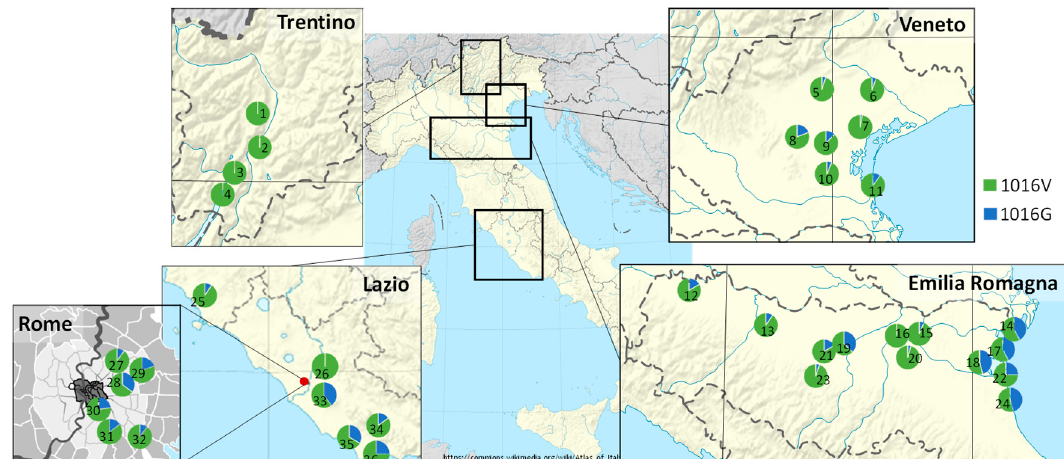
Figure 3. Allele frequency for wildtype (1016V = green) and mutated (1016G = blue) alleles in position 1016 of the vssc gene in Aedes albopictus populations from 36 sites across five Italian regions. Numbers identify sample sites according to Table 1. Map modified from map created by Wikimedia Commons users Sting and NordNordWest; CC BY-SA 3.0.